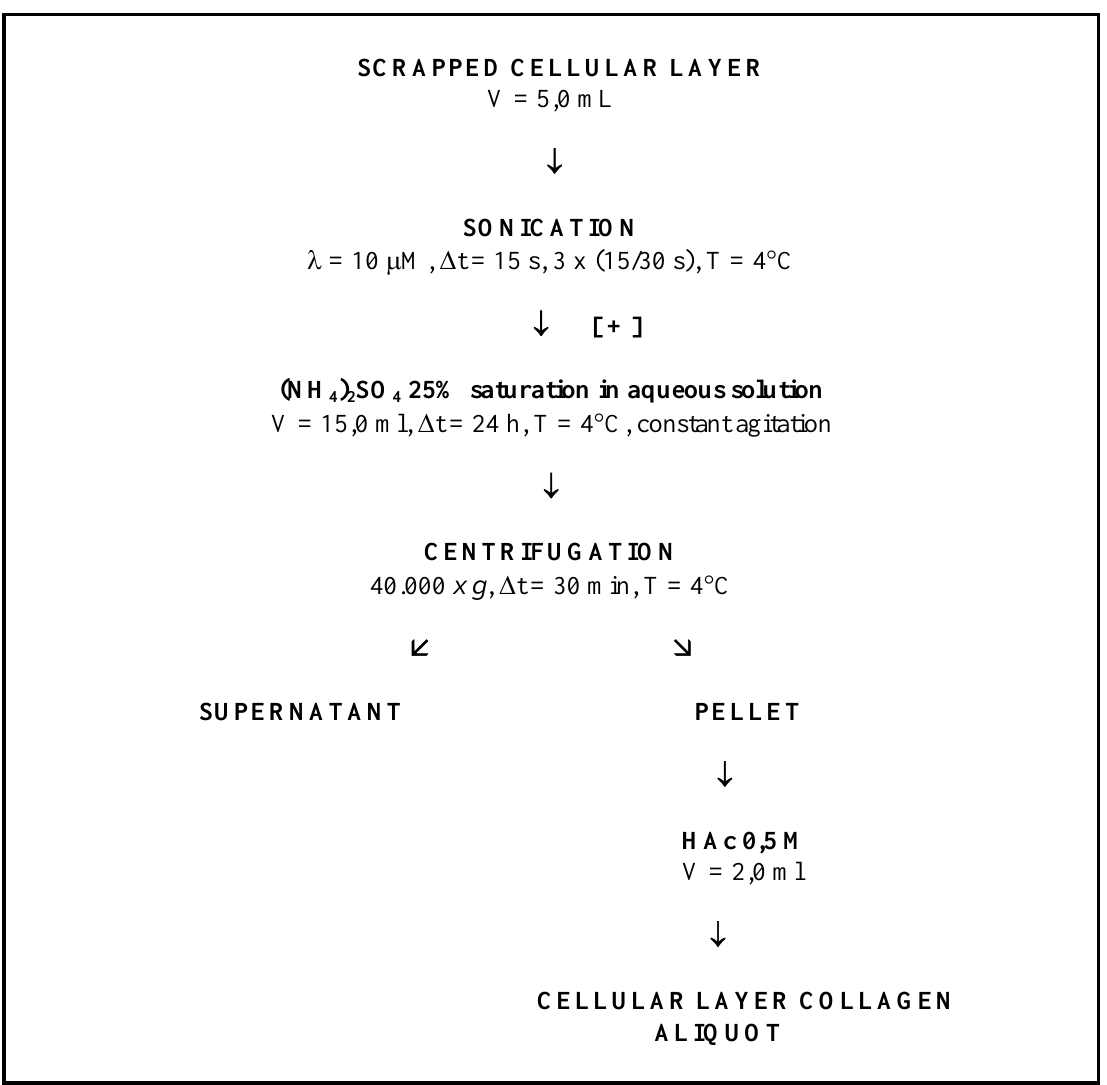
FIGURE 1 - Process of total protein and collagen extraction from the cellular layer. [+] - aliquots of total protein from the cellular